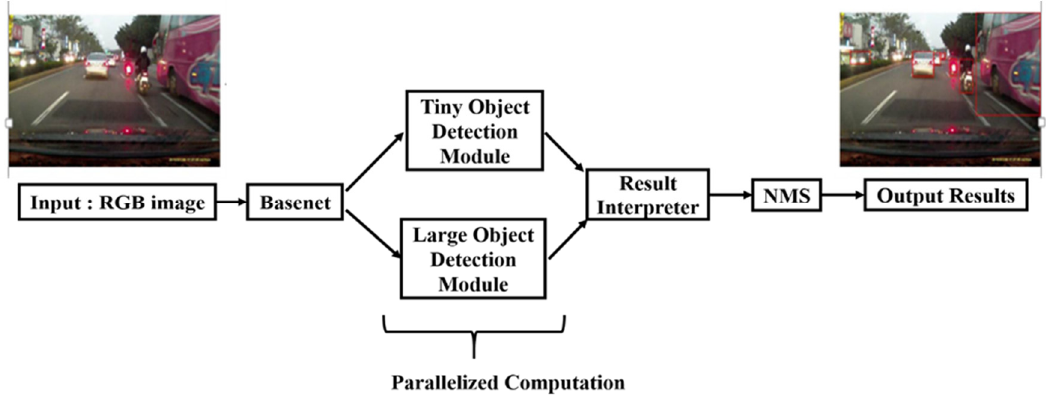
Figure 2. Object detection system with proposed task-specific bounding box regressors (TSBBRs). Given a color image as input, general features are extracted by the shared backbone. With these features as input, TSBBRs fetch and decode their own related information followed by coordination and class prediction simultaneously. Finally, all predicted boxes would be merged and passed into the non-maximum-suppression (NMS) procedure to eliminate the redundant boxes.